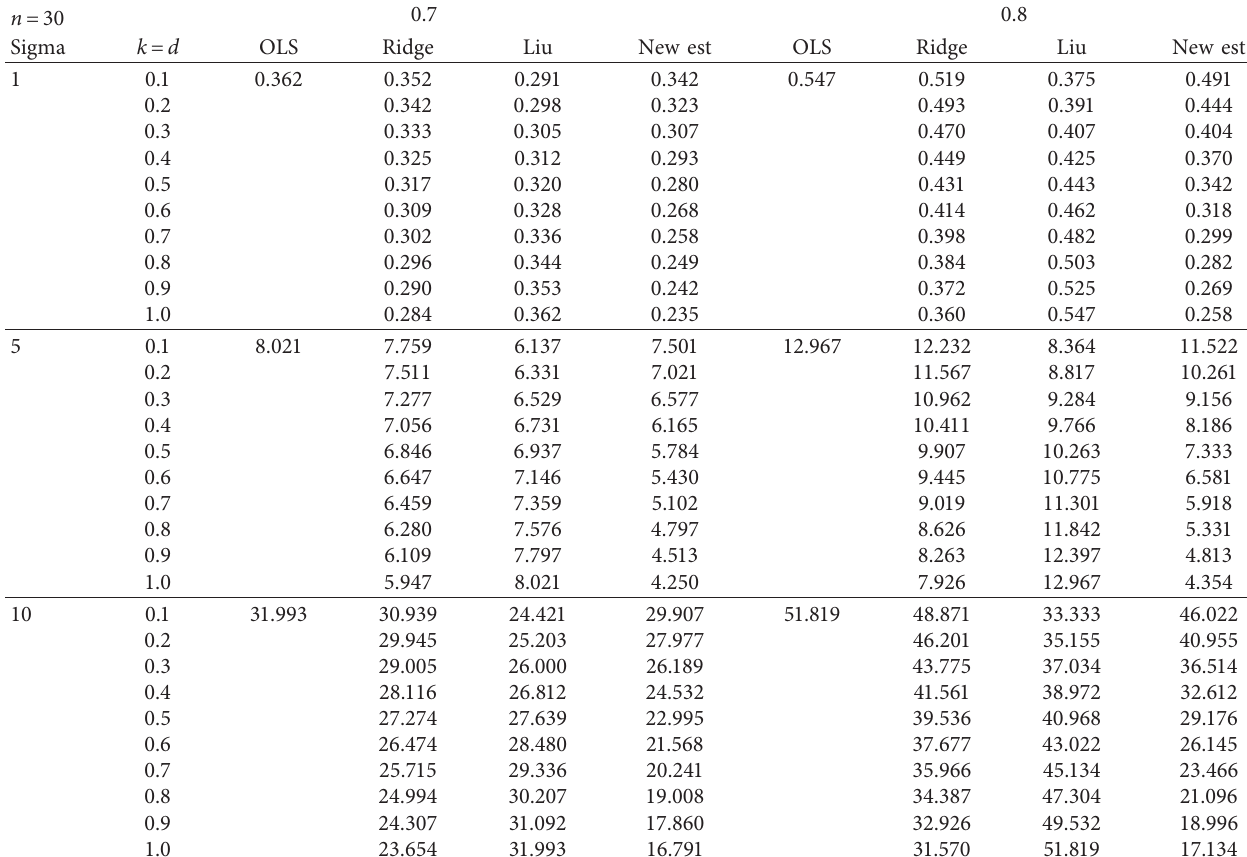
Table 1: Estimated MSE when n � 30, p � 3, and ρ � 0.70 and